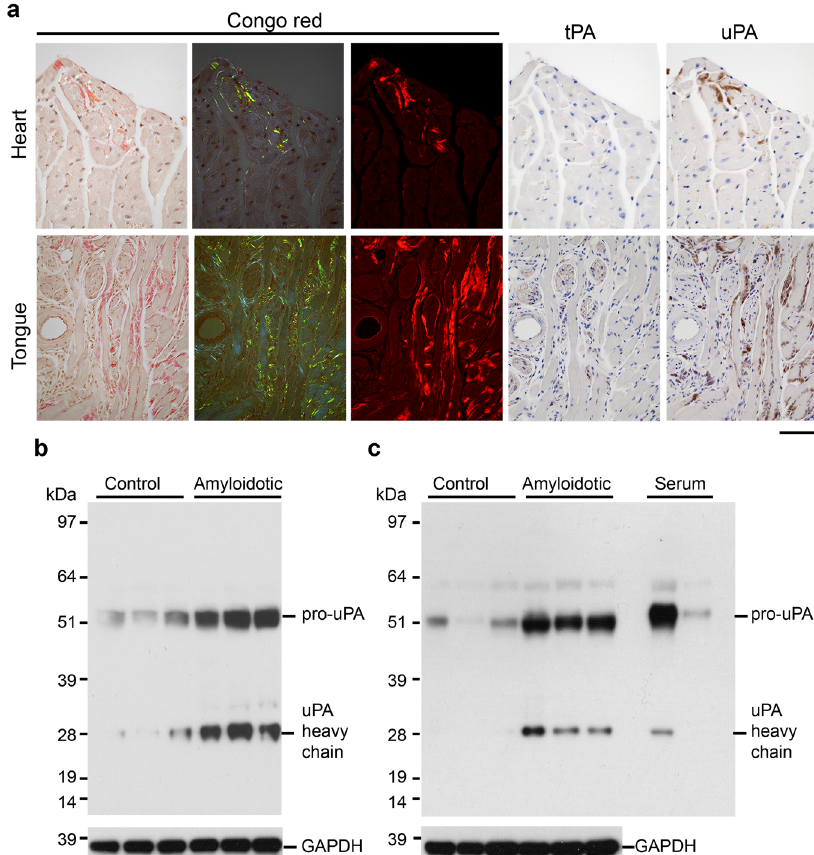
Fig. 8 Relationship between plasminogen activators and amyloid. a Adjacent sections of human TTR S52P amyloid-containing heart and tongue stained with Congo red to show amyloid or probed with anti-tPA or anti-uPA af fi nity-puri fi ed antisera (representative of results seen with six mice). The patterns of anti-tPA immunoreactivity were indistinguishable from those of normal control tissues (Supplementary Fig. 9). The amyloid deposits in heart and tongue were strongly immunoreactive when probed for uPA. Additional strong immunoreactivity in tongue was observed in mast cells, indistinguishable from that seen in normal control tissue (Supplementary Fig. 9). b , c Western blot showing greater amounts of uPA in amyloidotic hearts ( b ) and tongues ( c ) than in controls ( n = 3 amyloidotic and 3 control mice). Amyloidotic tissues contained more pro-uPA, the precursor of active uPA, as well as the heavy chain of active uPA; the antibody used for this analysis does not react with uPA light chain. GAPDH was used as a sample processing control for the tissue extracts. Scale bar: 50 µ m (heart); 100 µ m (tongue). Source data are provided as a Source Data fi